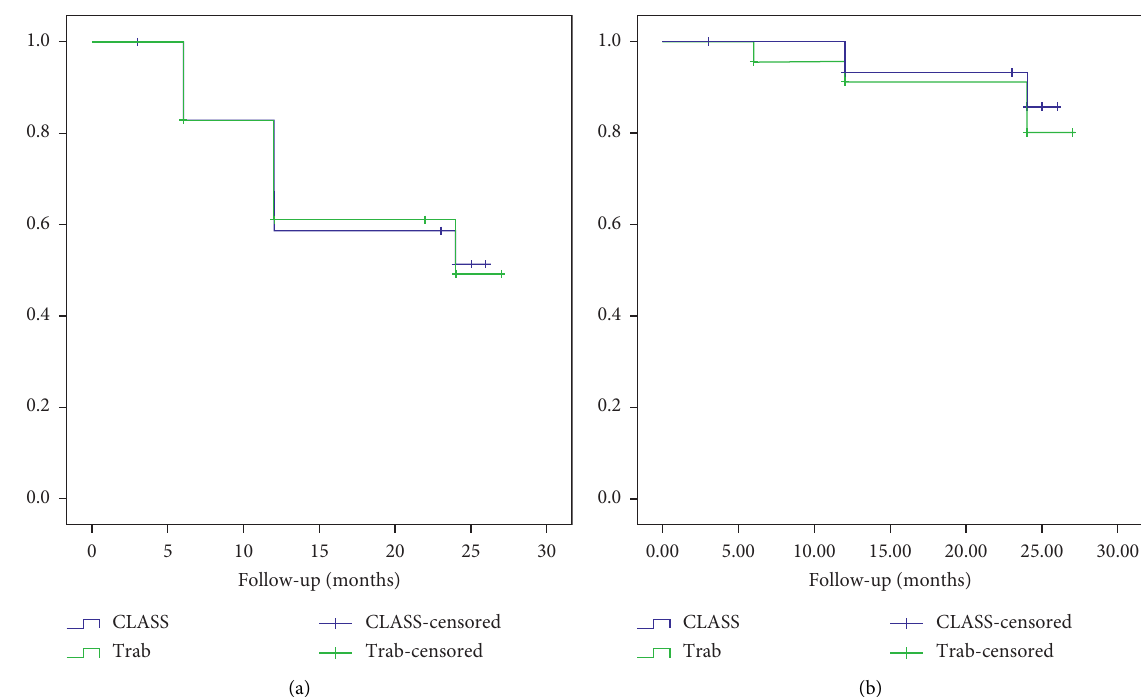
Figure 1: (a) Kaplan–Meier cumulative survival curves of complete success rate for the CLASS group and Trab group. (b) Kaplan–Meier cumulative survival curves of qualified success rate for the CLASS and Trab groups.